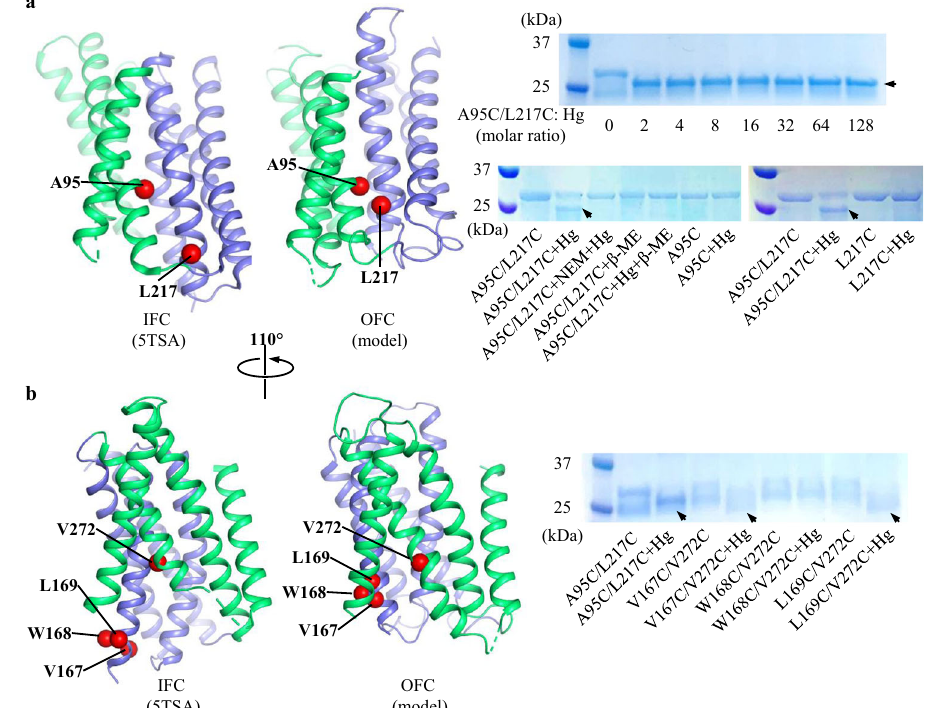
Fig. 8 | Hg 2+ -mediated chemicalcrosslinking ofBbZIPtovalidate the proposed OFC. a Crosslinking of the A95C/L217C variant. The protein was puri fi ed in DDM, incubated with HgCl 2 and then applied to non-reducing SDS-PAGE. The shifted bands after Hg treatment are indicated by arrows. The same batch of the puri fi ed protein was treated differently as indicated to con fi rm that the band shift is attributed to cysteine reacting with Hg 2+ . The single cysteine variants (A95C and L217C) were treated in the same way as the double variant. b Crosslinking of the